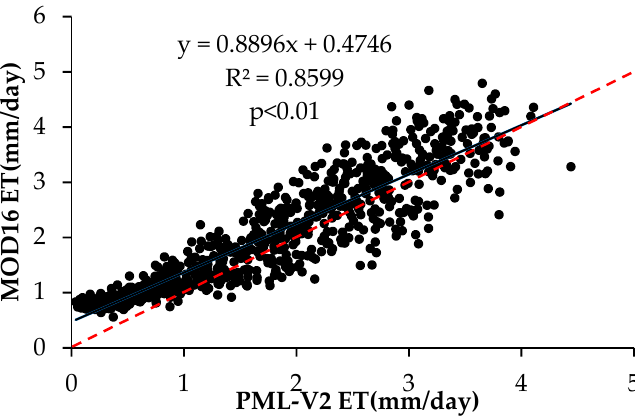
Figure 3. Scatter plots of MOD16 ET against PML-V2 ET. The interannual variation of ET and its components are shown in Figure 4. The annual ET ranged from 549 to 644 mm across the whole study period, and the mean annual Ec, Es, and Ei were 328.49, 173.07, and 83.56 mm, respectively, which accounted for 56.06%, 29.64%, and 14.3% of ET, respectively. Es showed a significantly decreasing trend from 2001 to 2020 with the rate of − 2.92 mm/y (R 2 = 0.56), while Ei showed a significantly increasing trend with the rate of 1.66 mm/y (R 2 = 0.59). The interannual changes of ET and Ec were not significant.